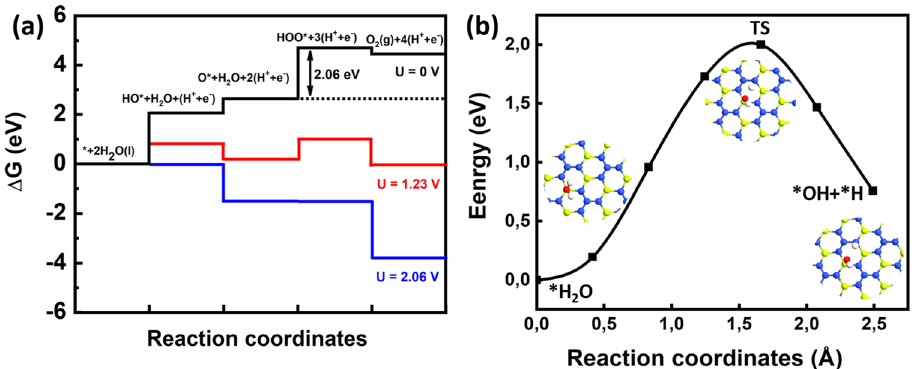
Figure 4. ( a ) Calculated free energy changes for the different intermediated reaction steps involved in the oxygen evolution reaction. ( b ) Minimum energy path for the dissociation of a water molecule into adsorbed OH and H species on a BeN 2